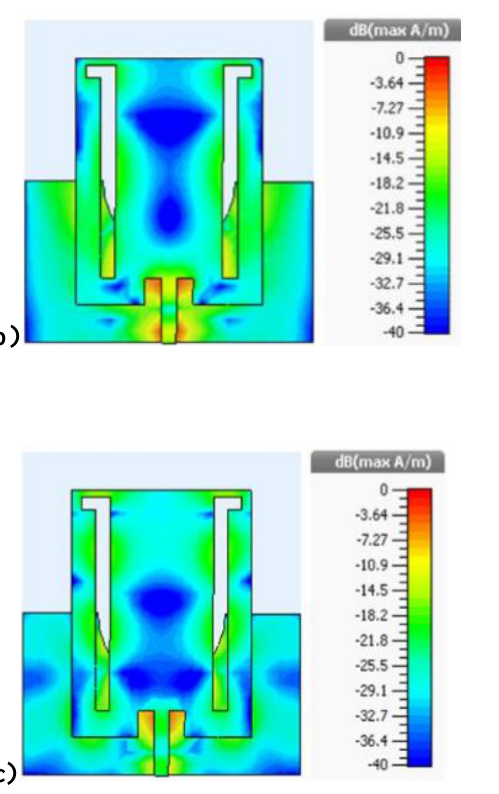
Fig. 6. Surface Currents at (a) 4.4GHz, (b) 6.2GHz and (c) 8.5GHz